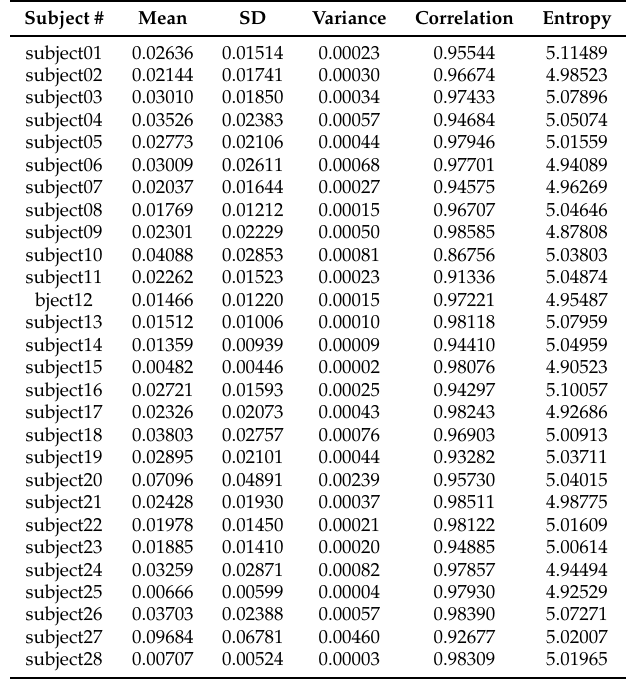
Table 3. Variability of the CU smart home dataset by pre-processing, which is used for clustering. Mean, Standard deviation, variance, auto-correlation, and entropy were calculated according Equations (2)–(6). Note that one subject participated in the experiment four times, resulting in data obtained from 28 subjects instead of 24.